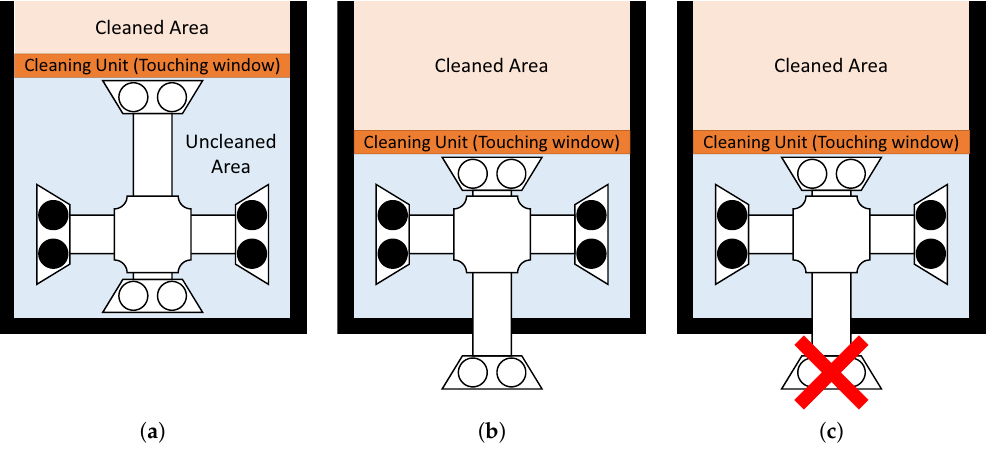
Figure 6. The movement sequence of an X – Y stage legged robot. The black coloured and white coloured circles represent suction cups with and without vacuum. ( a ) Vacuum inside the suction cups in the vertical direction are released; ( b ) the robot tries to make a downward movement; ( c ) suction cups fails to make contact with the surface and the surface is left